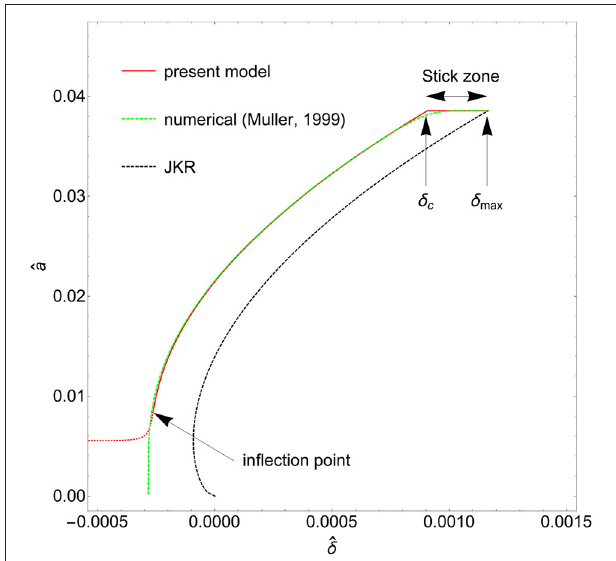
FIGURE 2 | The dimensionless contact radius ˆ a = a / R in terms of the dimensionless penetration ˆ δ = δ/ R . Curves are shown for JKR theory (black dashed line), Muller’s numerical model (green dashed line), and proposed model (red solid